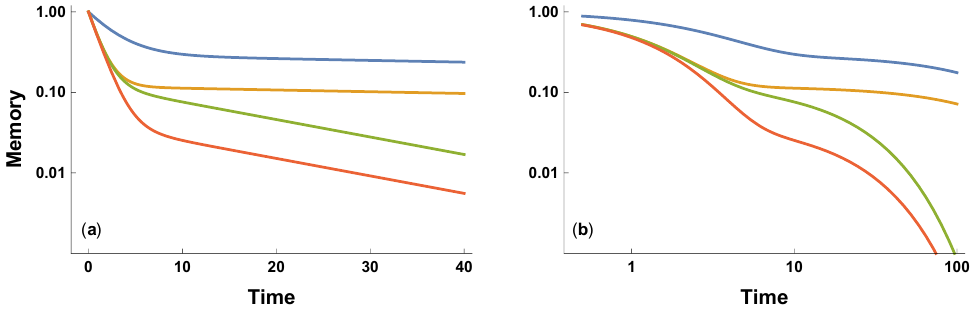
Figure 1. Biexponential decay of a signal in Equation (1). The same parameters are used for the plots on ( a ) semi-log axes and ( b ) log-log axes. The parameters for the curves from top to bottom are: ( a , b , c ) = ( 0.35,0.005,0.408 ) , ( 0.85,0.005,0.134 ) , ( 0.85,0.05,0.143 ) , ( 0.78,0.05,0.043 ) . The parameters match Figure 2 of Candia et al. [9], associated with their parameterization given in Equation (2) and the parameter equivalences: a = p + r ; b = q ; c = r / ( p − q ) ; and N = 1. The inverse parameter equivalences are also useful: p = ( a + bc ) / ( 1 + c ) ; q = b ; and r = c ( a − b ) / ( 1 + c )